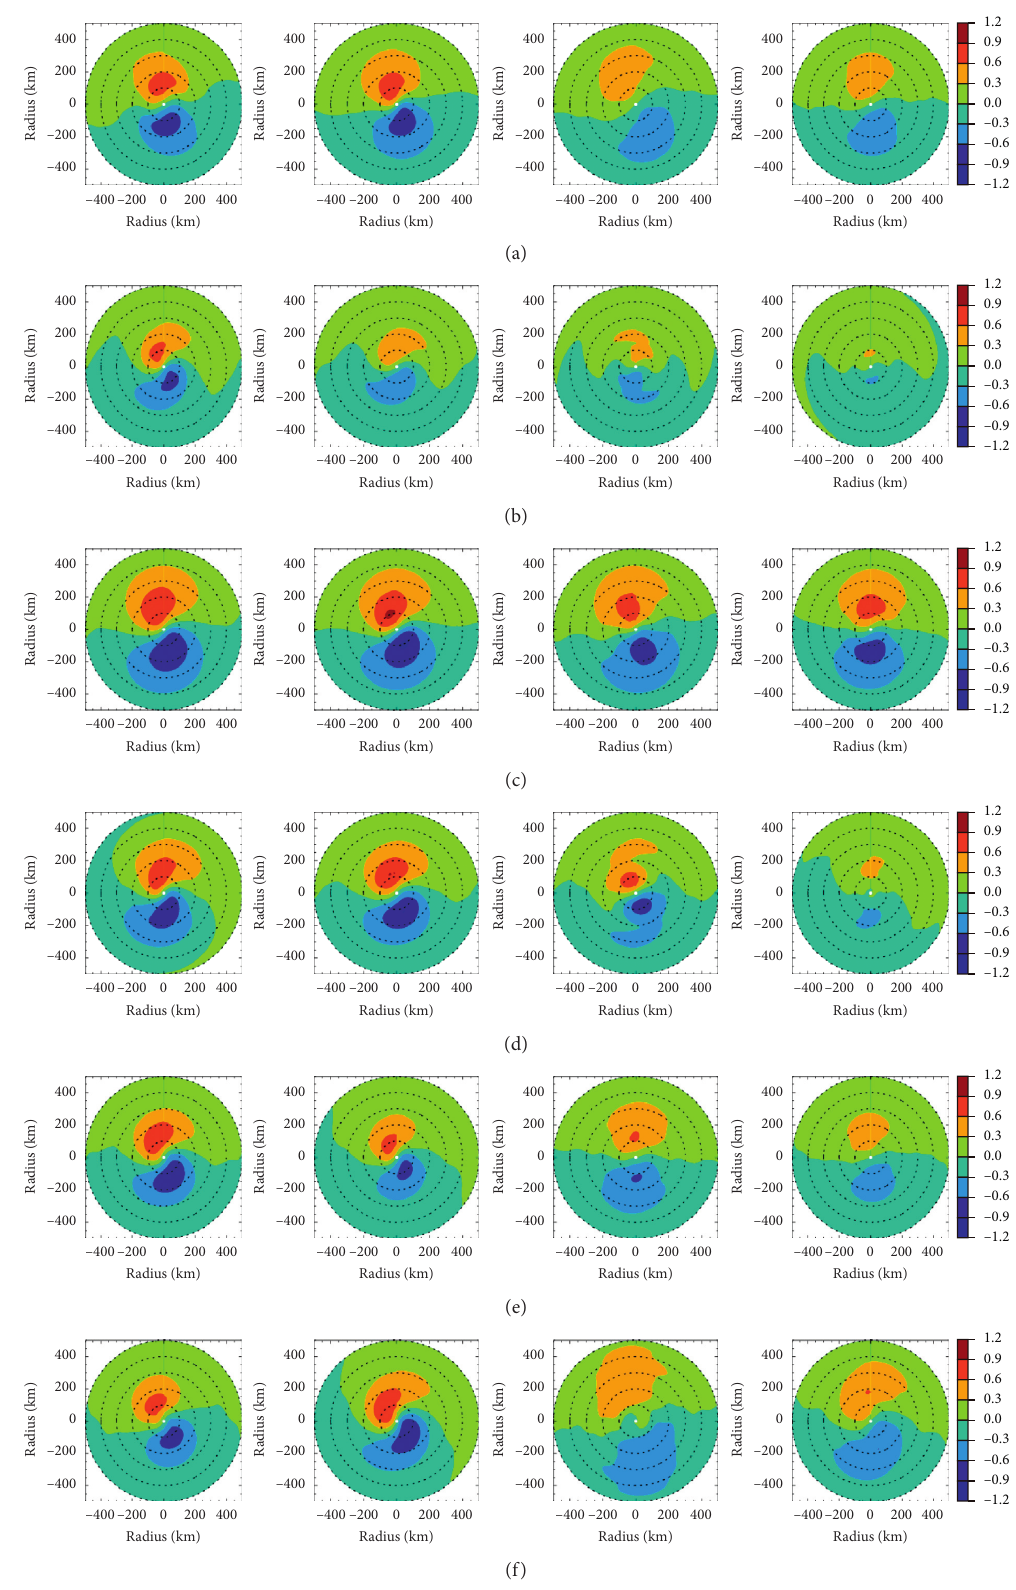
Figure 4: The composite shear-relative wavenumber 1 asymmetry for (I) off-shore, (II) preland, (III) in-land with high-PV, and (IV) in-land with low-PV over (a) ATL, (b) EPA, (c) NWP, (d) NIO, (e) SIO, and (f) SPA. The shear direction rotated clockwise with 0 ° pointing to the